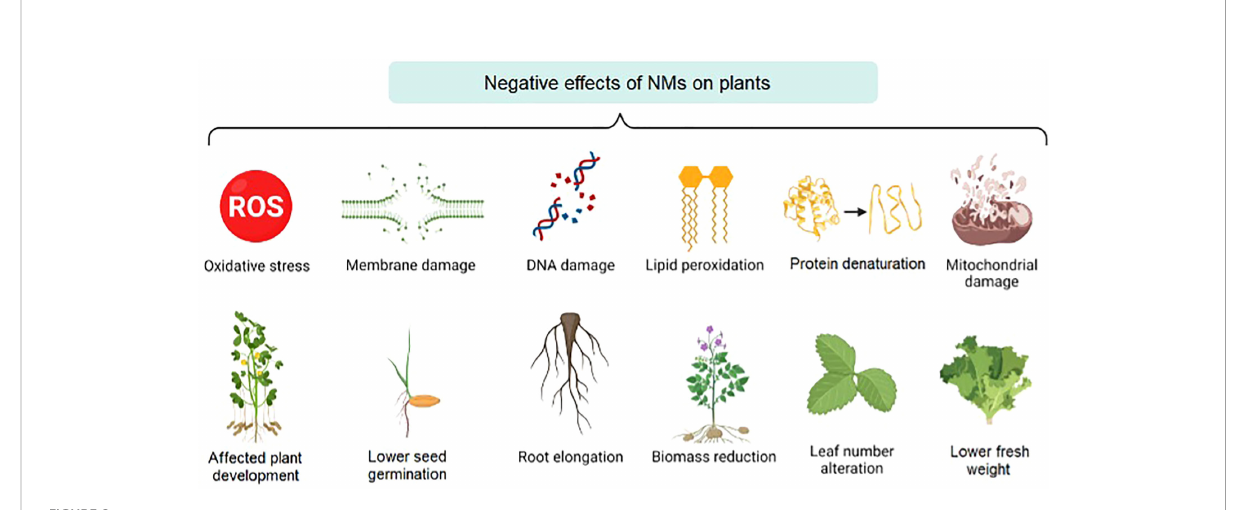
FIGURE 2 Physiological response of plants by the toxicity mechanism of